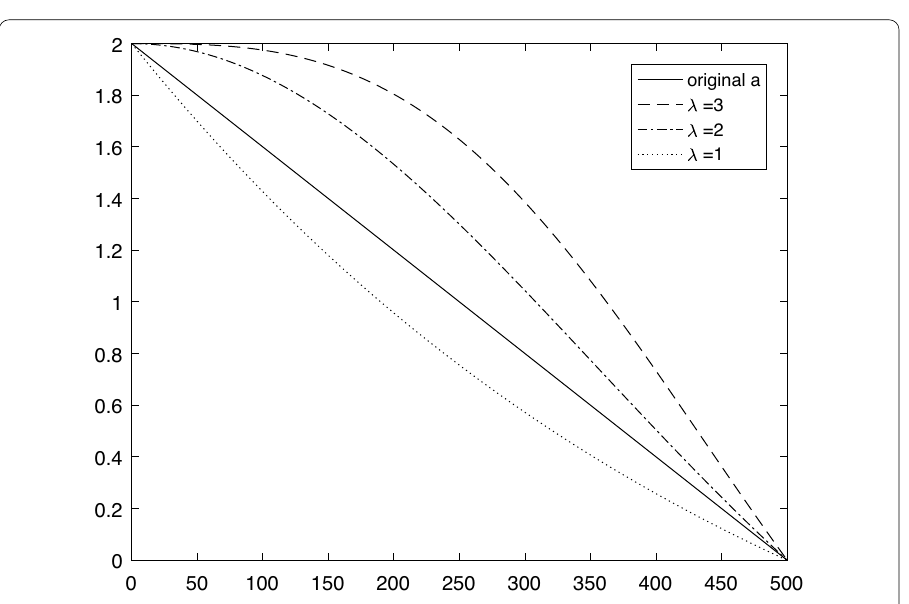
Fig. 2 Change of the improved convergence factor